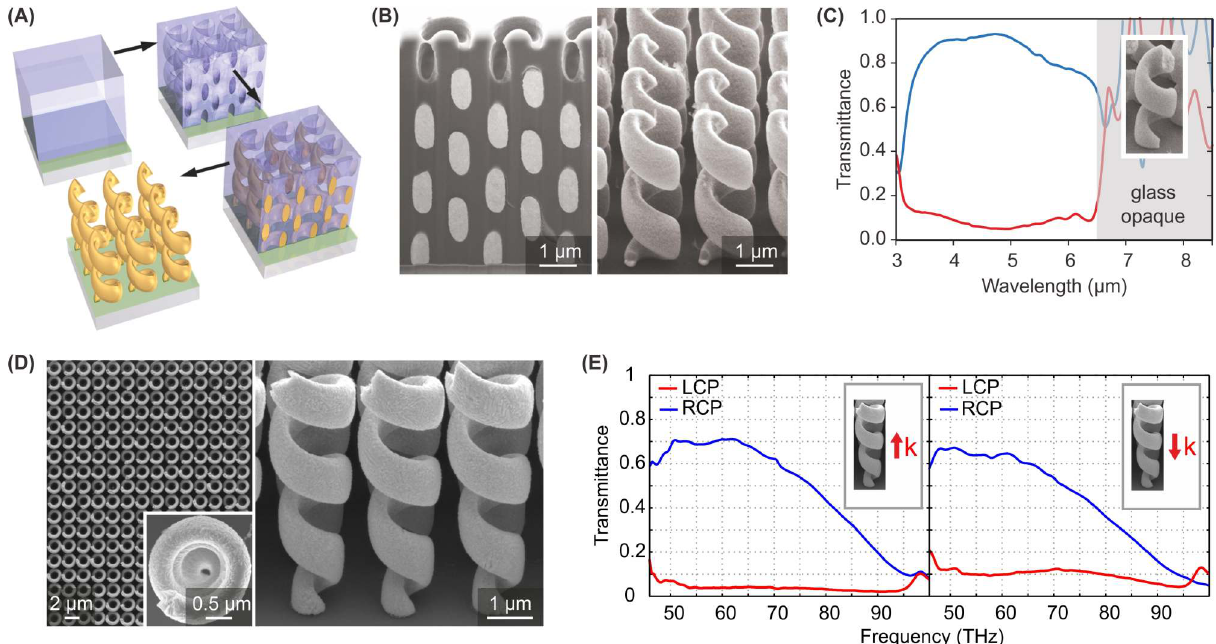
Figure 4: (A) The three major steps during fabrication via conventional direct laser writing in a positive-tone photo resist are illustrated. In a first step, voids are created with DLW in a spin-coated positive-tone photo-resist layer. Subsequently, the voids are filled with gold em- ploying electrochemical deposition. In a final step, the photo resist template is removed via oxygen plasma etching. (B) Scanning electron micrographs of gold helical metamaterials, both before and after oxygen plasma etching. (C) Experimental transmittance spectra of the array depicted in (B). Incident circular polarizations LCP and RCP are color-coded by red and blue curves, respectively (A-C adapted with permission from [18]. Copyright 2009 American Association for the Advancement of Science). (D) Scanning electron micrographs of